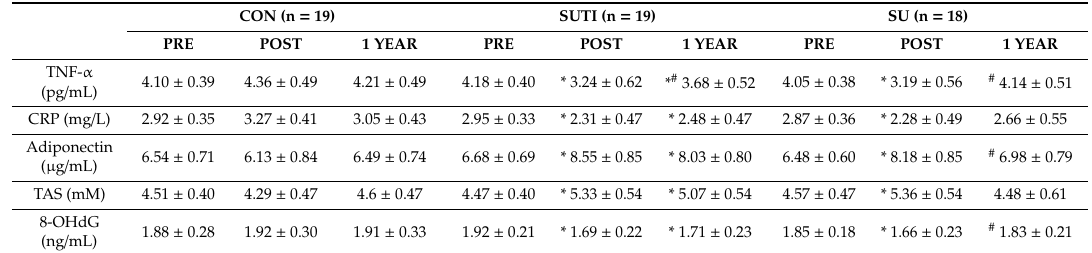
Table 2. Changes in blood chemicals at baseline (PRE), after 8 week summer camp (POST), and after 10 month follow-up